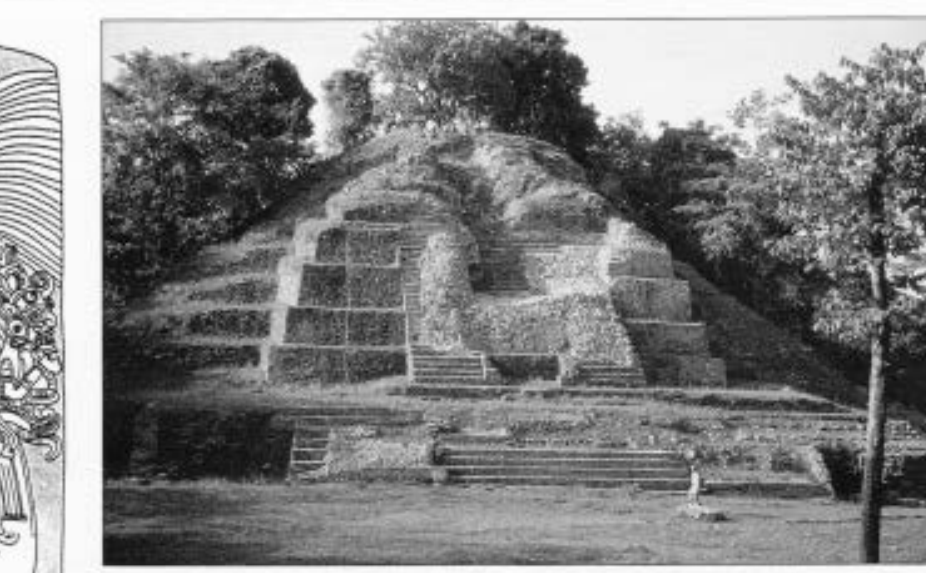
Figure 3 Structure Nl 0-9 at Lamanai, a temple building of the Classic and Postclassic periods.